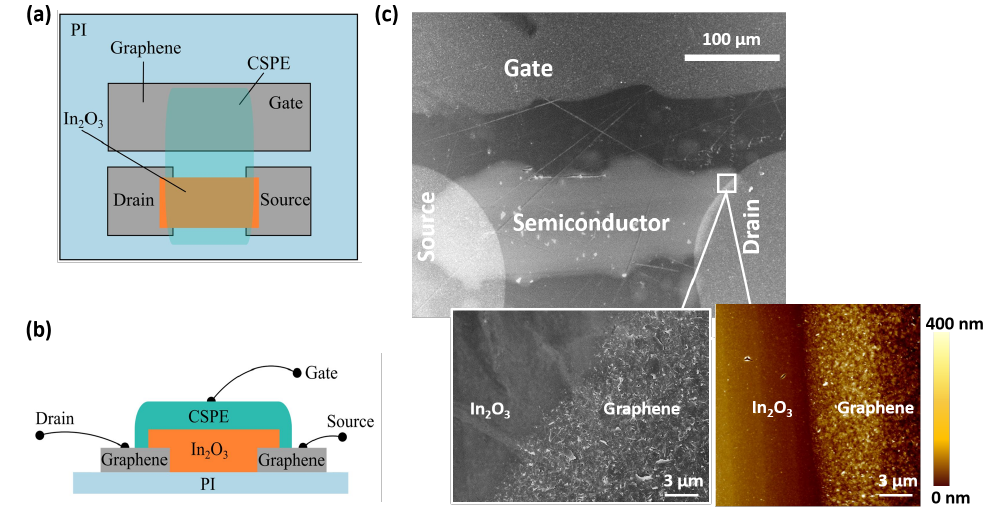
Figure 2. ( a ) Top and ( b ) side views of the printed transistor. ( c ) Top-view SEM image of the transistor structure. Inset shows SEM and AFM micrographs of the interface between graphene film and In 2 O 3 . Average graphene flake size was about 200 nm. Atomic force micrography shows that the graphene ink had higher roughness of more than 200 nm as compared to that of the indium oxide film, which had a roughness of 6